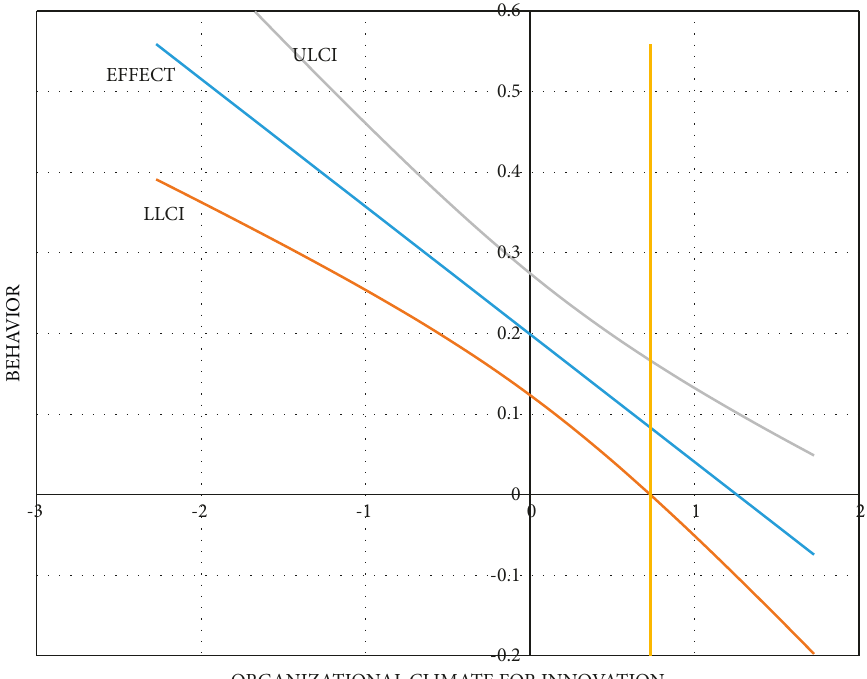
Figure 3: Effect of organizational climate for innovation on job insecurity and working withdrawal